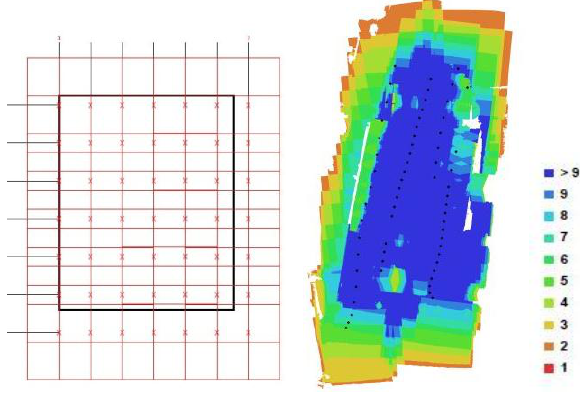
Figure 9. RPAS flight